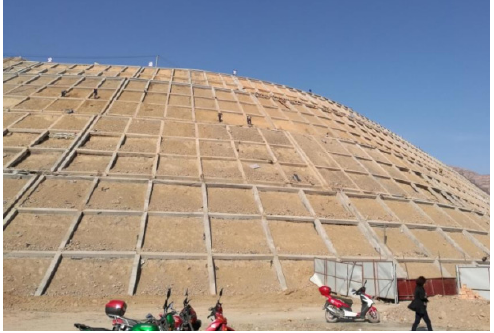
Figure 2. Filled-slope reinforced by a frame with prestressed anchor-plates.